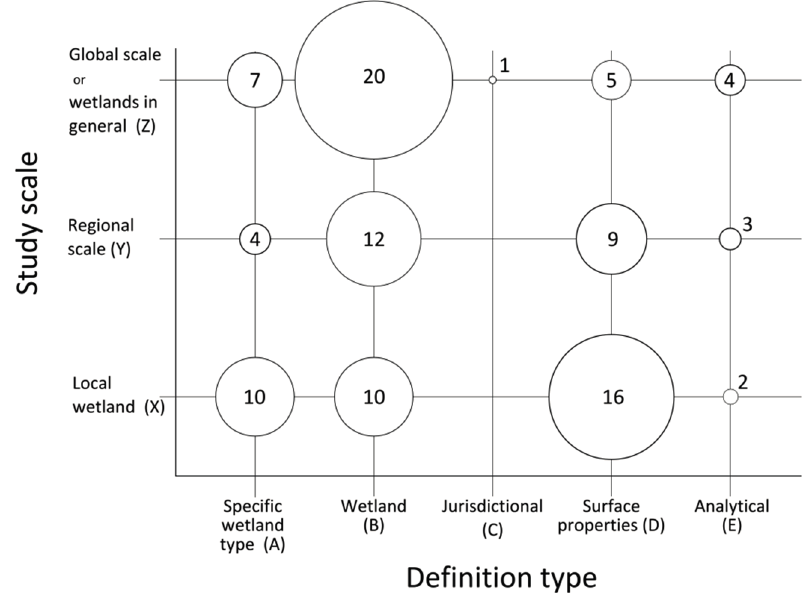
Figure 2. Wetland definitions as identified in the literature analysis. The sizes of circles inside the matrix reflect the number of definitions grouped in each class. Table 2 provides classification descriptions. Table 2. Summary of wetland definitions as plotted in Figure 2. Letters A–E indicate the thematic group relevant to each definition; X, Y and Z values indicate the scale of each study (X = local scale; Y = regional scale; Z = global scale or wetlands in